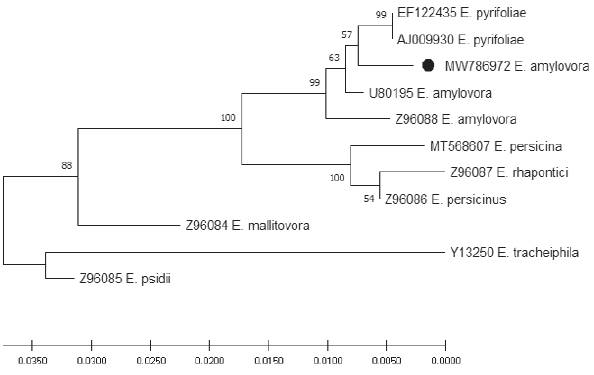
Figure 2. Phylogenetic analysis based on 16S rDNA gene sequenc- es from diverse Erwinia spp. strains. The evolutionary history was inferred by using the Maximum Likelihood method and Tamura- Nei model (Tamura and Nei, 1993). The tree with the greatest log likelihood (-2704.47) is shown. The percentage of trees in which the associated taxa clustered together is shown next to the branches. Number of boostrap replicates = 500. Initial tree(s) for the heuristic search were obtained automatically by applying Neighbor-Join and BioNJ algorithms to a matrix of pairwise distances estimated using the Tamura-Nei model, and then selecting the topology with supe- rior log likelihood value. The tree is drawn to scale, with branch lengths measured in the number of substitutions per site. This anal- ysis involved 11 nucleotide sequences. There were a total of 1285 positions in the final dataset. Evolutionary analyses were conducted in MEGA X (Kumar et al. , 2018). The sequence obtain in the pre- sent study is marked with a black dot.